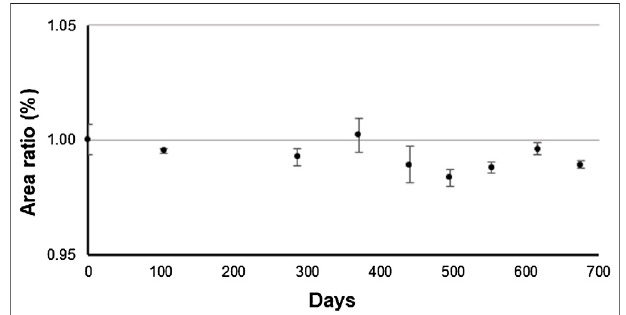
FIGURE 9 | Time course of the main peak of the antibody solution of previous production batch stored at − 80 ° C by triplicate measurement using cation exchange chromatography. Y -axis represents the relative peak area ratioofthemain peak.This measurement wasperformed asalong-term stability